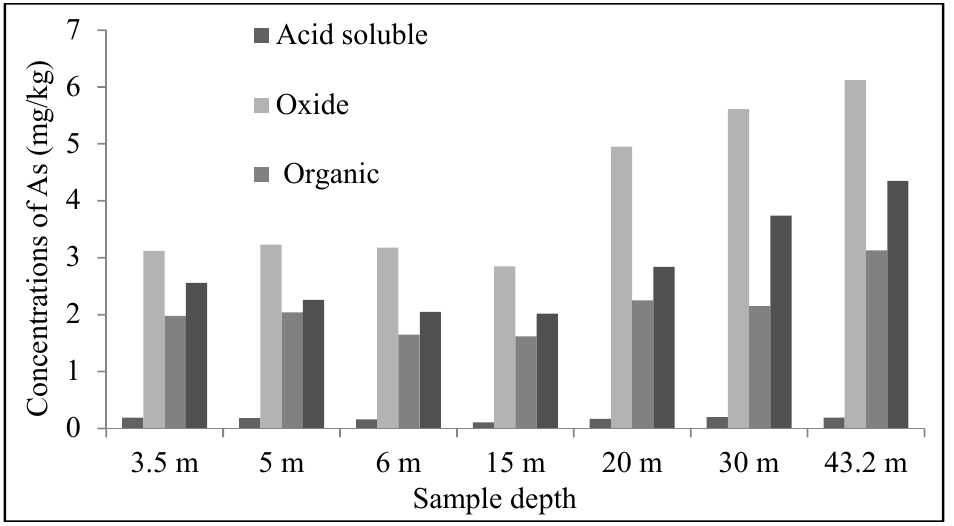
Figure 5. Results of sequential extraction analysis of arsenic in different phases in selected sediment samples of Marua